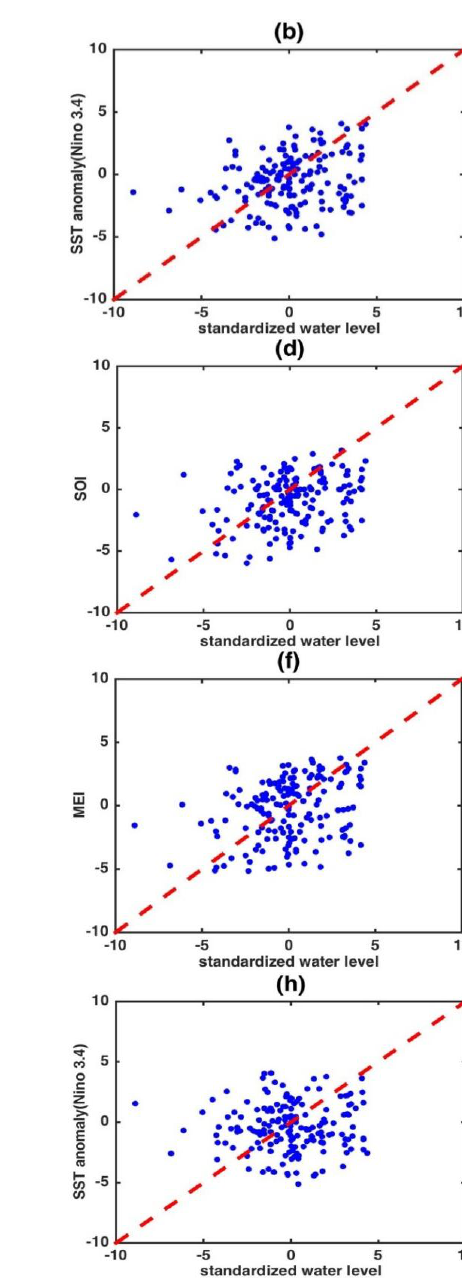
Figure 5. Standardized water level against ( a , b ) the SST anomaly; ( c , d ) the SOI; ( e , f ) the MEI with 7-month time shift; and ( g , h ) the SST anomaly without time shift. The left-hand side gives the time series comparisons of ENSO indices, and the right-hand side shows the corresponding scatter plots.